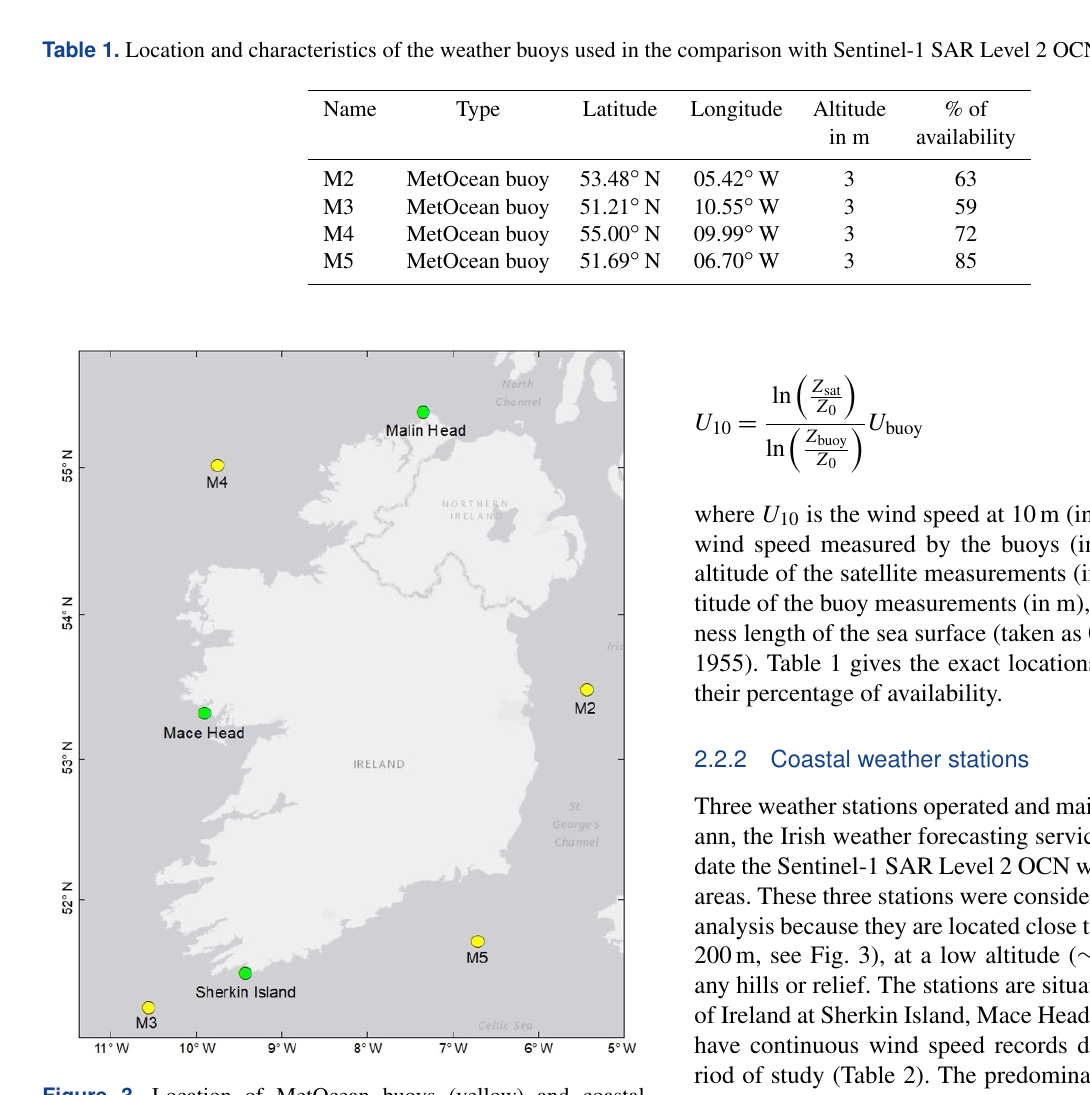
Figure 3. Location of MetOcean buoys (yellow) and coastal weather stations (green) used in the validation of Sentinel-1 SAR surface